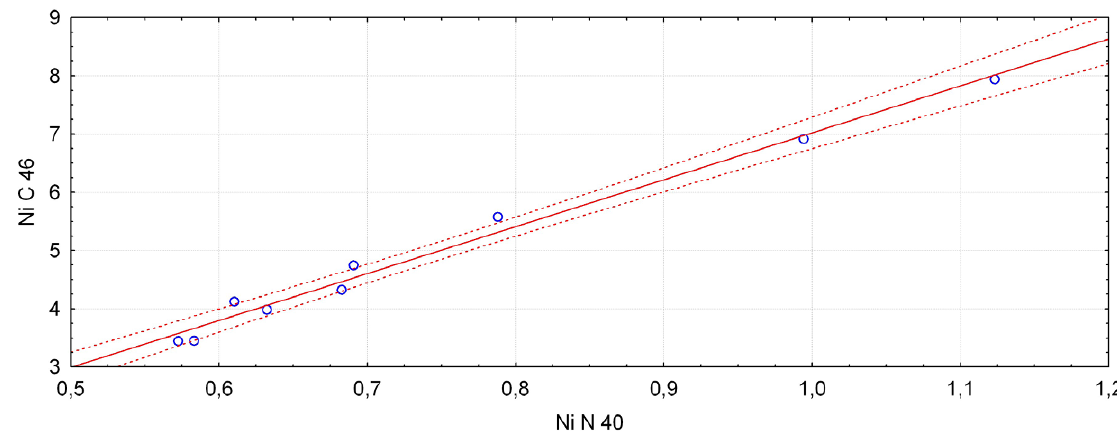
Figure 9. Relationship between nickel concentration in different samples - Ni N (40) and Ni C